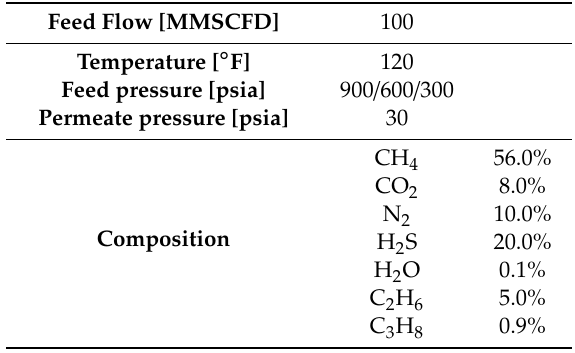
Table 2. Raw gas stream